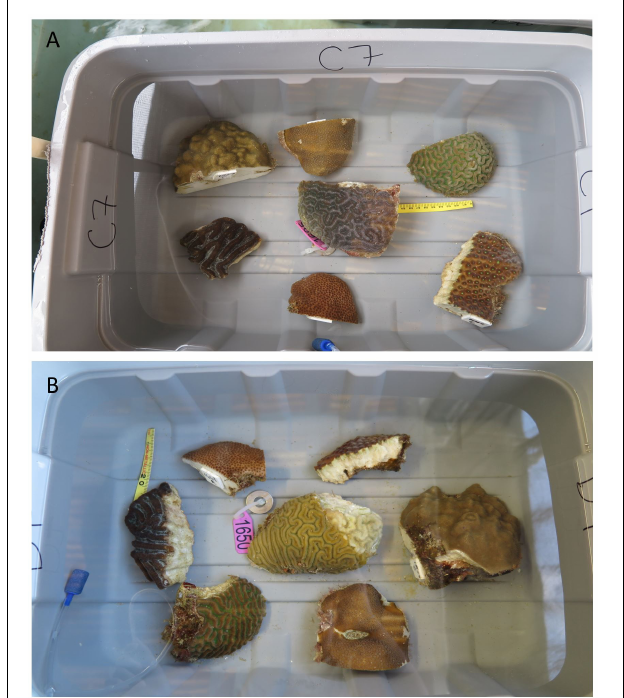
FIGURE 1 | Experimental Design. (A) One control replicate containing an air stone, ruler, a visually healthy central colony of Diploria labyrinthiformis , and fragments of 6 different species: Colpophyllia natans, Montastraea cavernosa , Orbicella annularis , Porites astreoides , Pseudodiploria strigosa, and Siderastrea siderea . (B) One disease exposure replicate containing an air stone, ruler, a diseased central colony of D. labyrinthiformis with lesion signs matching SCTLD, and fragments of 6 species. The central coral is a distinct genotype from the D. labyrinthiformis colony in the control replicate (A) , but the experimental fragments surrounding it are the same genets used in the control replicate (A) . This paired design was replicated with 8 distinct sets of experimental